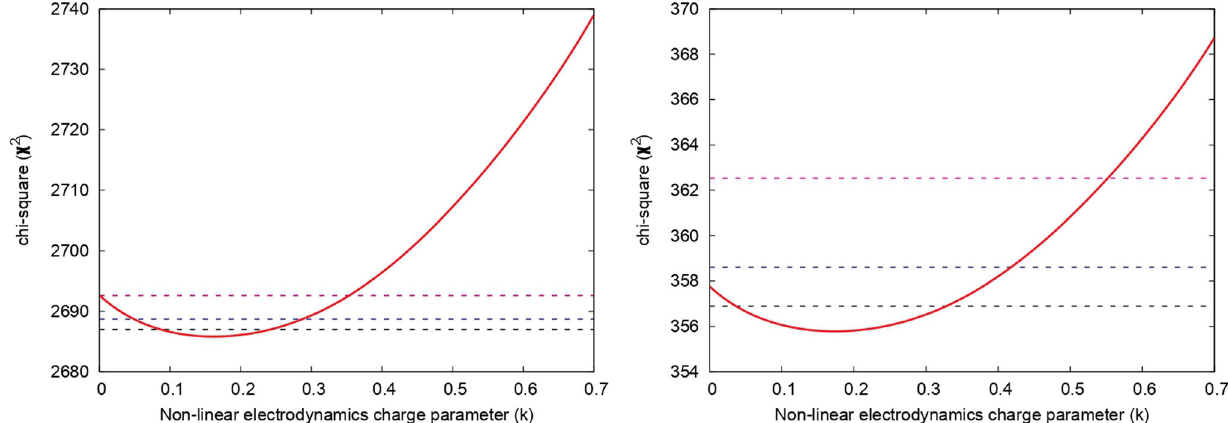
Fig. 2 The above figure illustrates the variation of χ 2 with the non- linear electrodynamics charge parameter k . This is shown for two choices of r out , namely, r out = 500 R g (left panel) and r out = 1000 R g (right panel). The figure clearly shows that χ 2 minimizes for a small but non-trivial value of the magnetic monopole charge parameter k (cid:2) 0 . 15